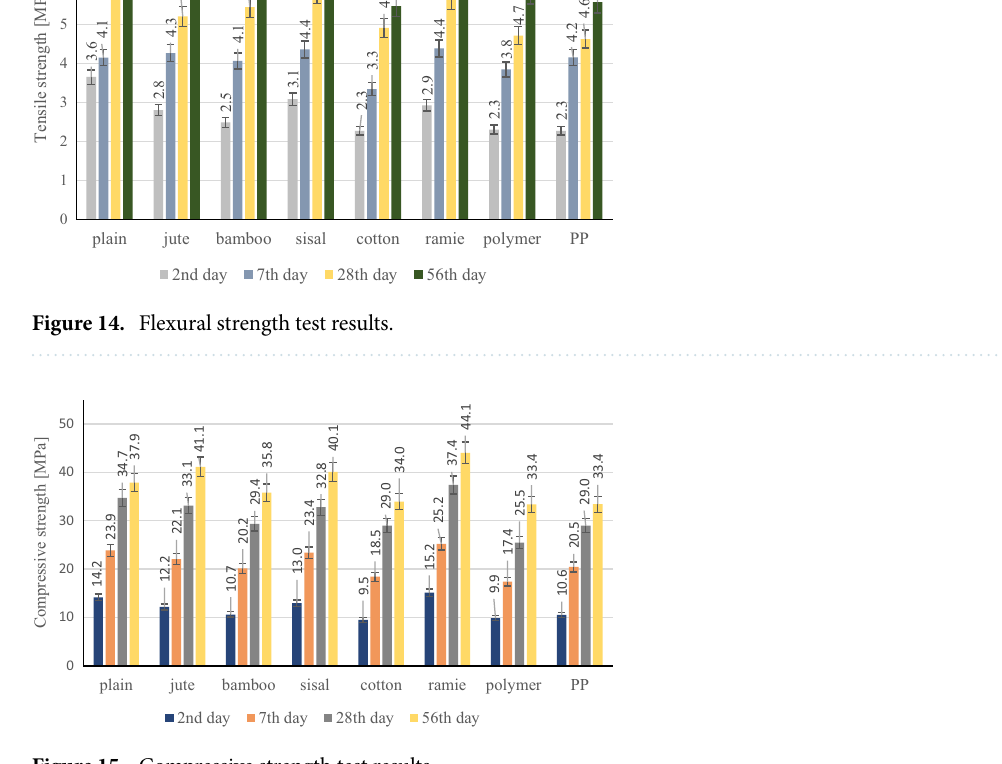
Figure 15. Compressive strength test